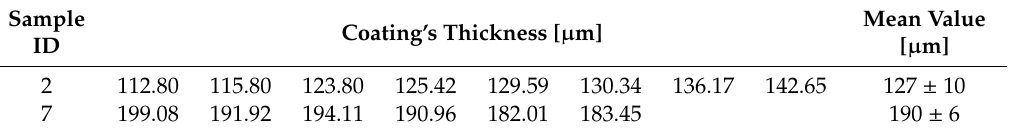
Figure 7. SEM images acquired in cross-section mode of samples 2 ( a ) and 7 ( b ). Some measured thicknesses are reported. Table 3. Coating’s thickness measured by the SEM acquired in cross section mode.